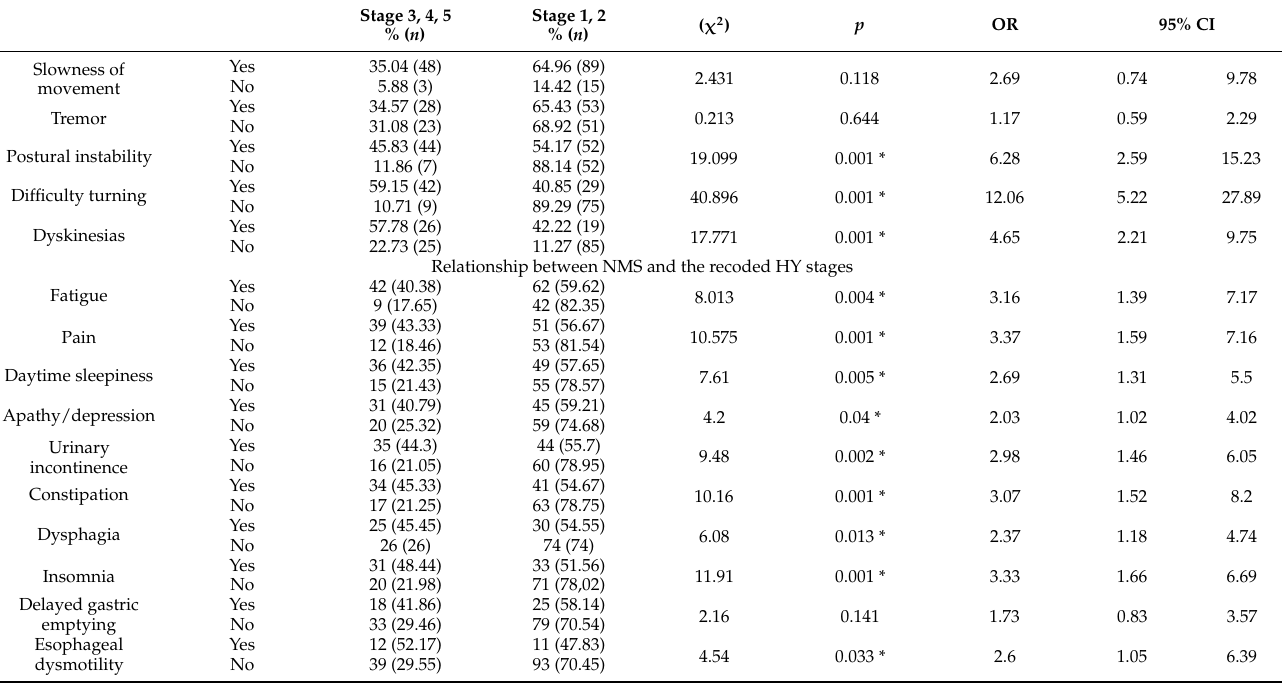
Table 6. Relationship between MS and NMS and the recoded HY stages.